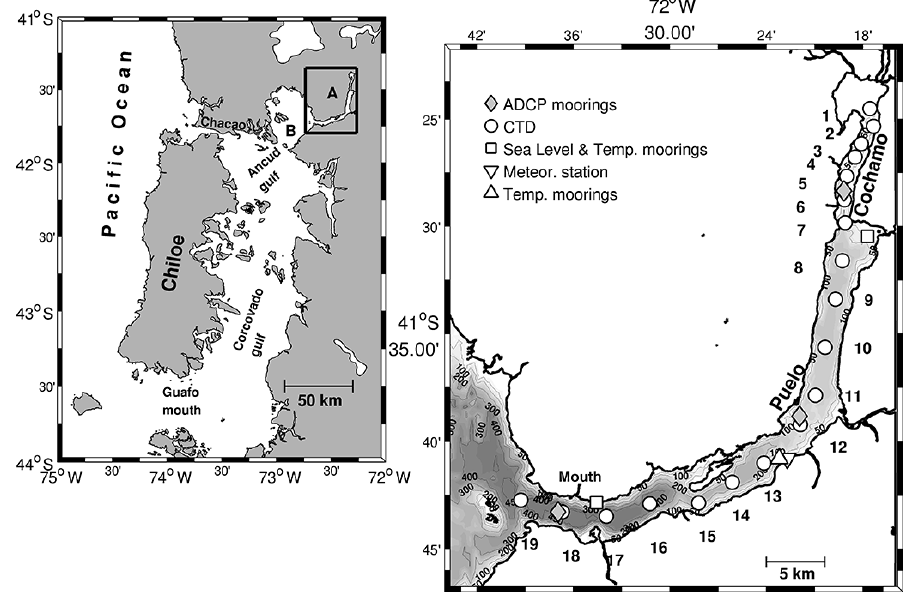
Figure 1. Study region and location of the measuring stations. The left panel shows the area of the Reloncaví fjord (a) . The location of the Reloncaví sound (b) is also shown. The right panel shows the study area (close-up view of a ) and the positions of all measurements. Numbers are CTD